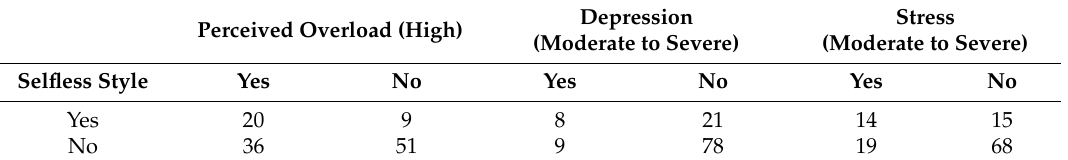
Table 5. Crosstab for Selfless Spiritual Coping, Perceived Overload, Depression, and Stress. Perceived Overload (High)